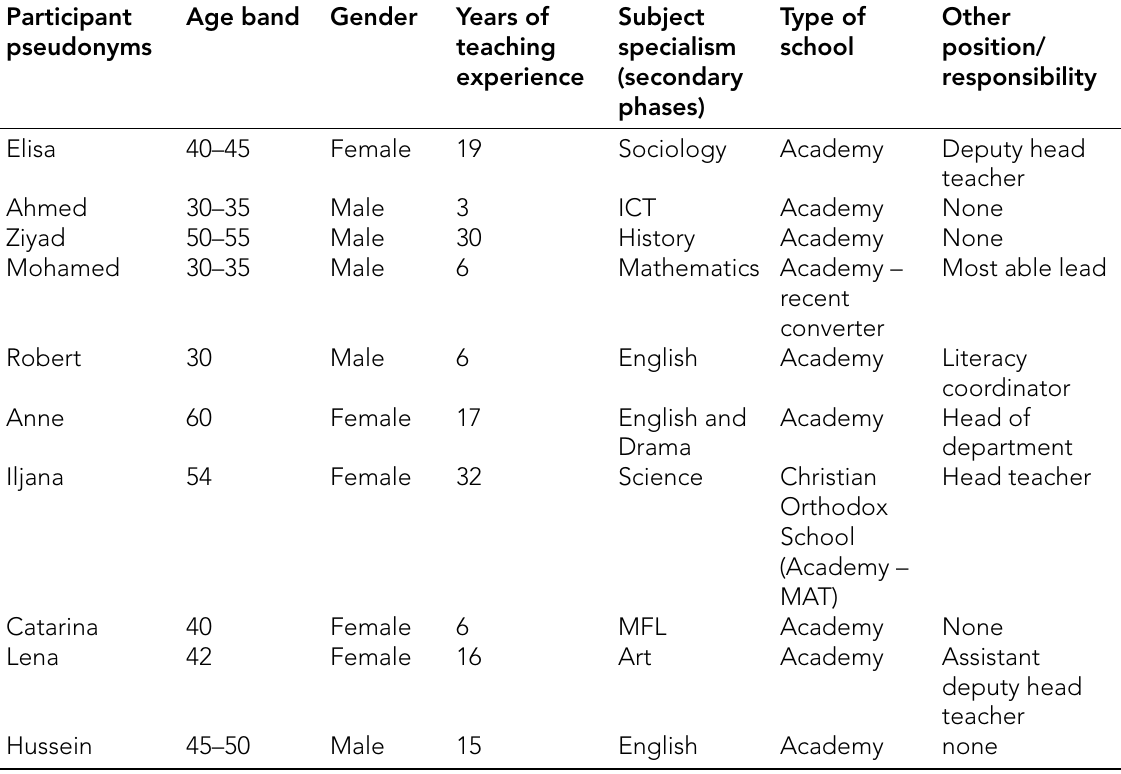
Table 1. Participant demographic information (Source: Authors,